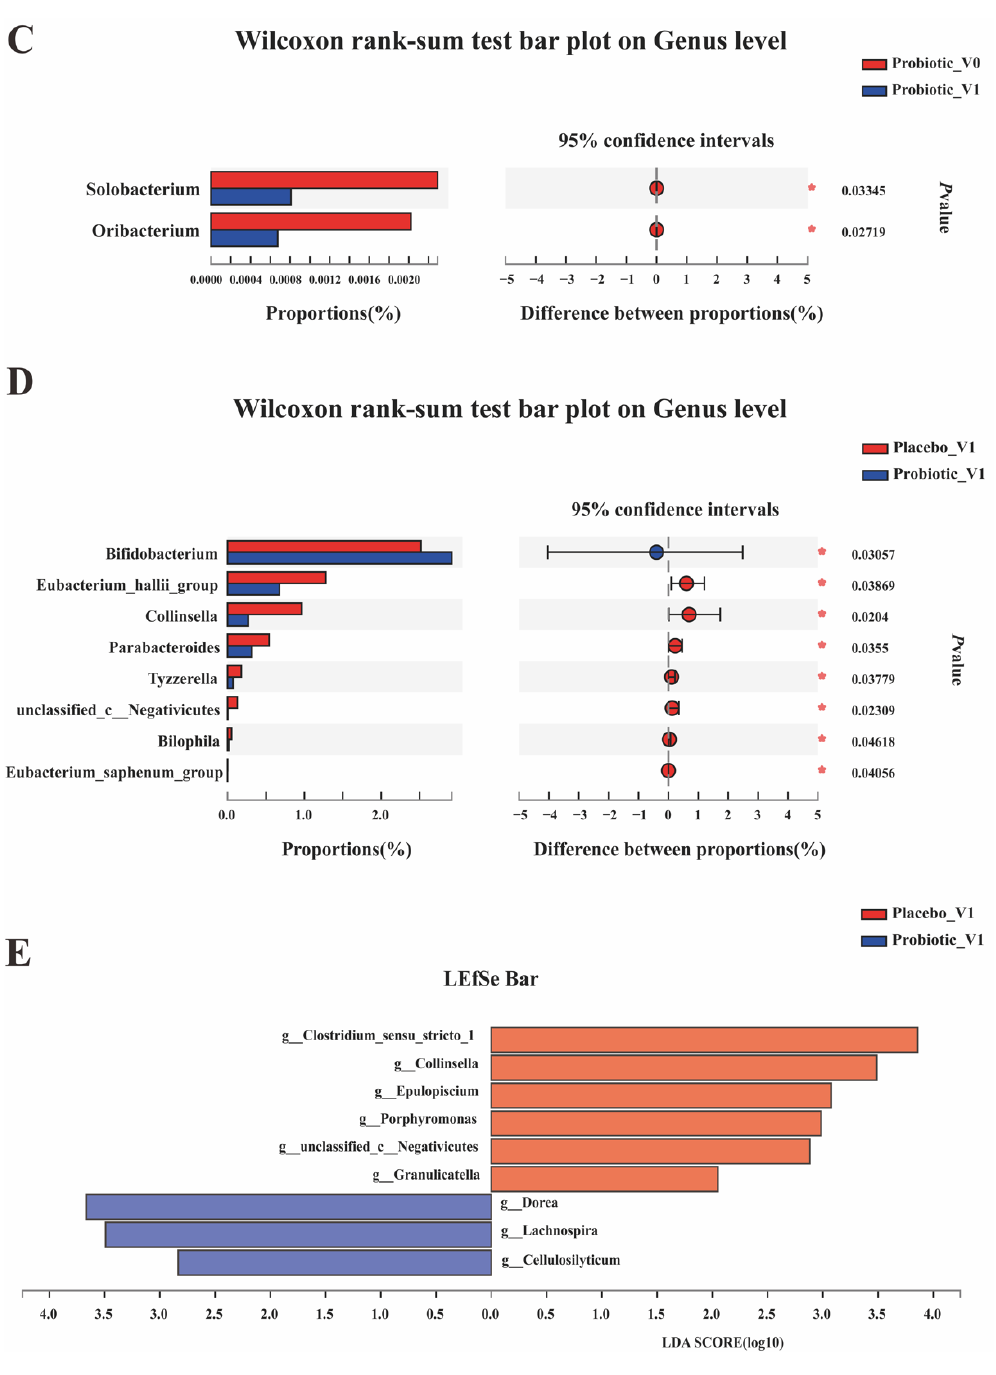
Figure 5. Effects of BB68S intervention on the composition of the gut microbiota. ( A ) Relative abundances of main phyla between groups. ( B ) Relative abundances of main genera ≥1% between groups. ( C ) Significantly different genera levels after intervention in the BB68S group. ( D ) Significantly different genera levels between 2 groups after intervention. ( E ) LEfSe analysis indicated significant differences between the 2 groups after intervention. * p ≤ 0.05. Placebo_V0: samples of the placebo group at baseline, Probiotic_V0: samples of the probiotic group at baseline, Placebo_V1: samples of the placebo group after intervention, Probiotic_V1: samples of the BB68S group after intervention.